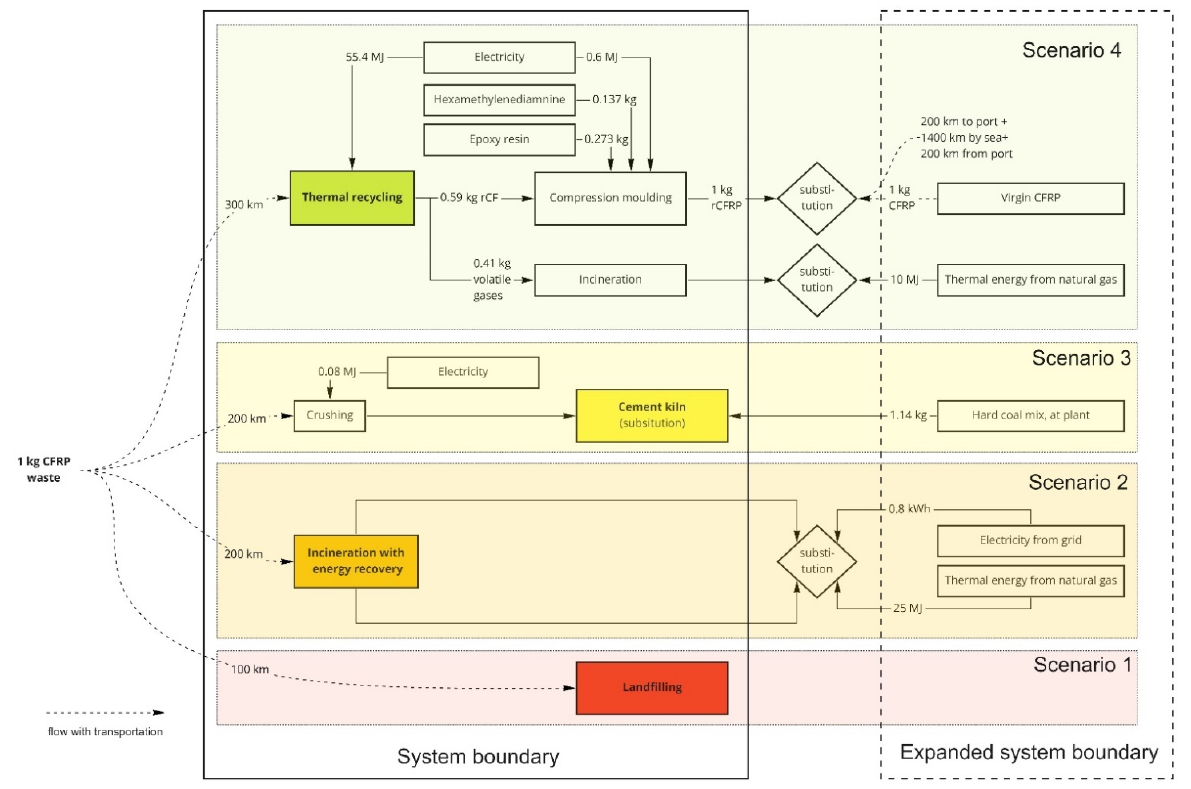
Figure 2. System boundaries of the studied and expanded systems for CFRP waste management.